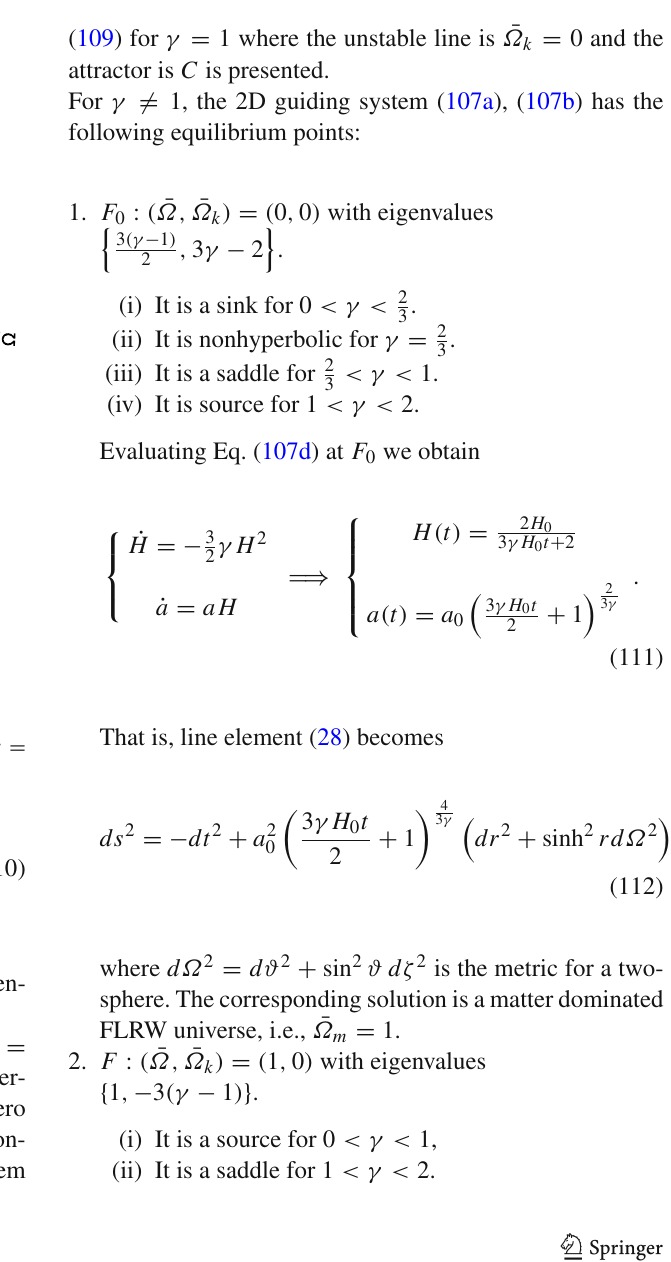
(109) for γ = 1 where the unstable line is attractor is C is